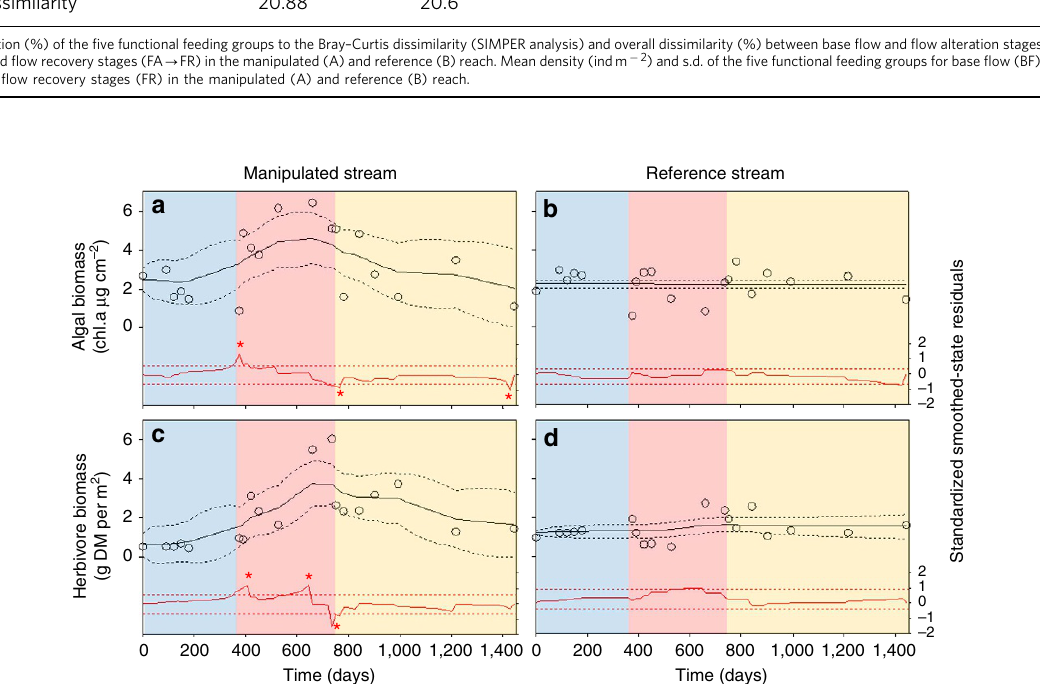
Figure 3 | Ecological time series. Time series (open dots), smoothed-state estimates (solid lines) and state 95% confidence level (dotted lines) of algal biomass (chl.a, chlorophyll a; a , b ) and herbivore biomass (DM = dry mass; c , d ) for the downstream reach of the manipulated stream and the reference stream. Red curves represent standardized smoothed-state residuals from state-space models for algae and herbivores time series. Dashed red lines are the 95% confidence intervals for a t -distribution. Red stars indicate when standardized smoothed-state residuals are beyond the dashed level lines. Blue, red and yellow regions indicate base flow, flow alteration and flow recovery periods, algal and herbivore biomass significantly increased (Fig. 4). When plotting our experimental data on Fig. 4 (blue and red dots and squares), we found that algal and herbivore biomass values before